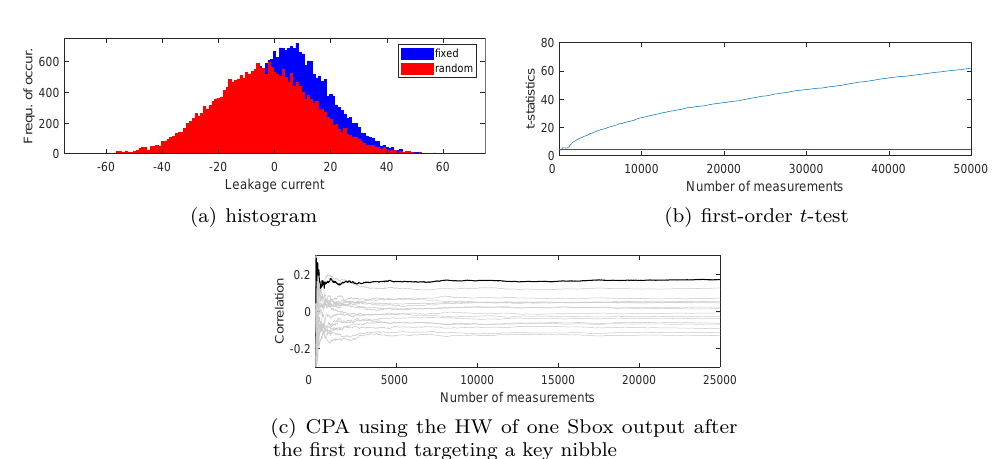
Figure 5: Leakage evaluation and attack using 50,000 fixed vs. random measurements of a nibble-serial implementation of the PRESENT-80 block cipher in 90 nm CMOS technology, recorded at 90 ◦ C and 1 . 6